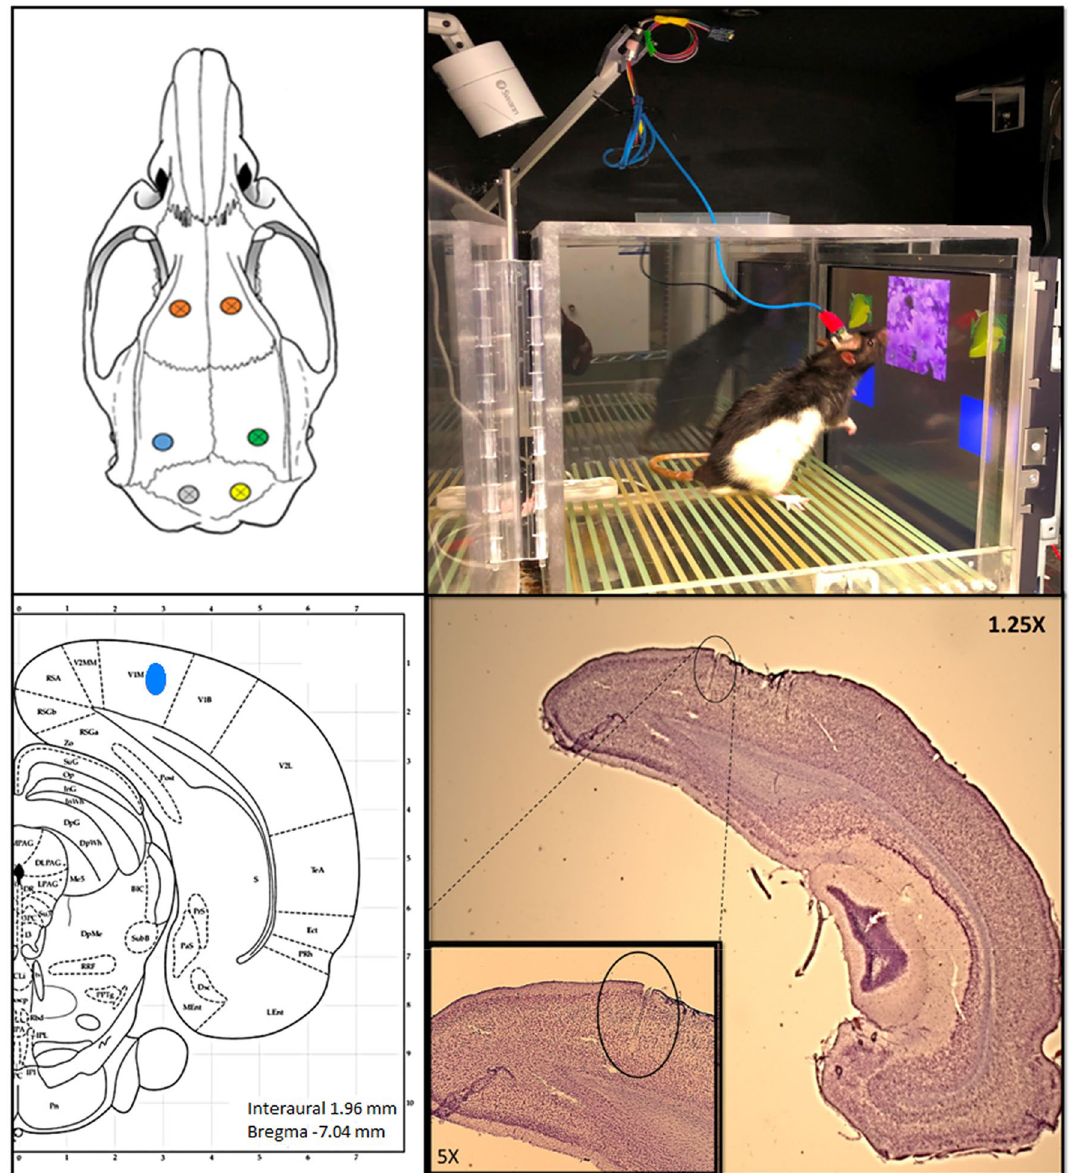
Figure 3. Upper left panel: electrode locations on rat skull (orange: bilateral screws on frontal region; blue: LFP wire in V1 area; green: screw on occipital region; yellow: ground screw; gray: reference screw). Upper right panel: photograph of the behavioral/recording setup. Bottom left panel: representative location of the V1 LFP wire on a rat brain atlas. Bottom right panel: representative histology image showing the LFP electrode placement in